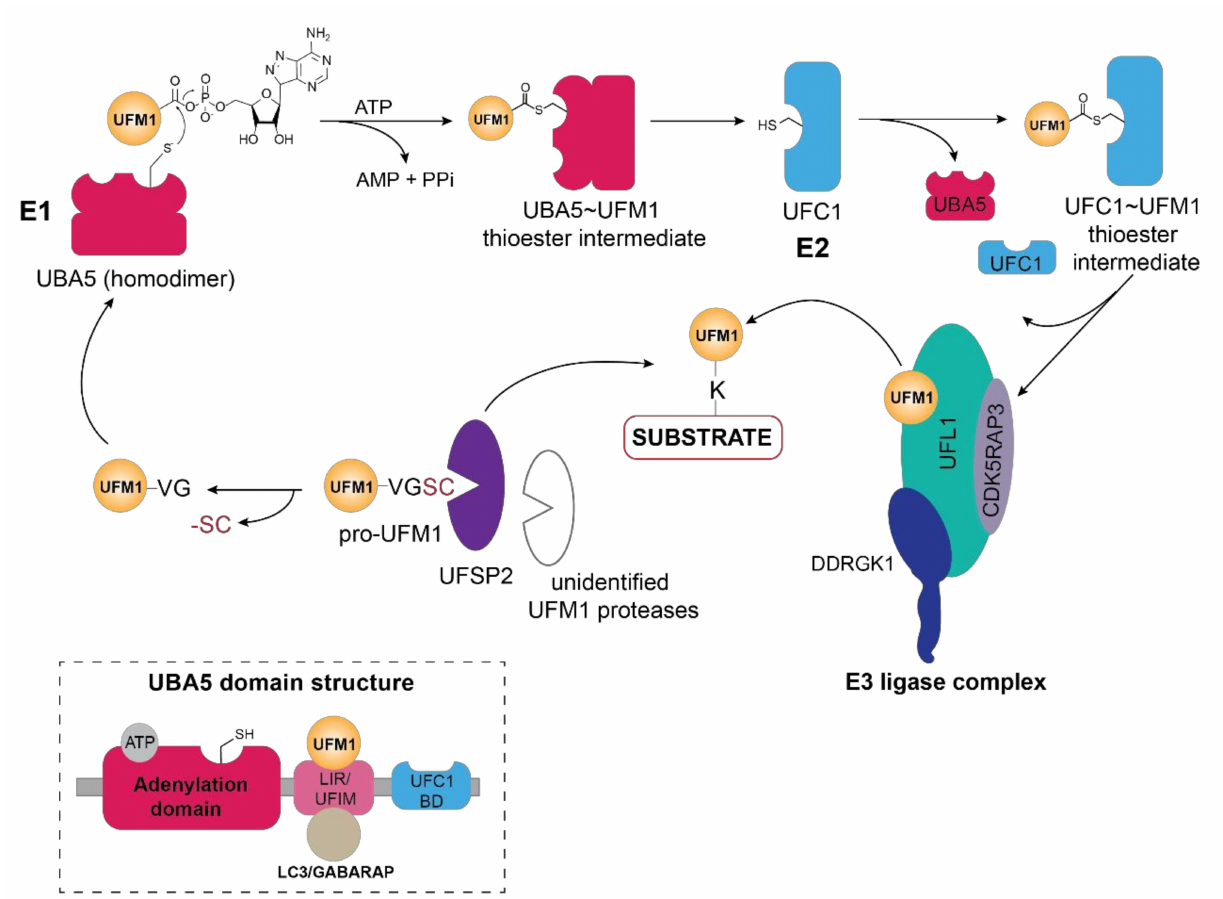
Figure 1. Schematic overview of the UFM1 cascade. In the initial step, the two terminal amino acids (serine and cysteine) are cleaved from pro-UFM1 by UFSP2 and presumably another unidentified UFM1-specific protease [26]. Prior to UFM1 adenylation at the exposed C-terminal glycine residue, UFM1 binds to the UFM1-interacting motif (UFIM)domain of UBA5 (E1), promoting its homodimer formation as well as subsequent UFM1 activation [18]. The UFM1 adenylate intermediate undergoes a nucleophilic attack by the active site cysteine residue of UBA5 yielding the UBA5 ~UFM1 thioester intermediate. Through a transthiolation reaction, activated UFM1 is transferred to the active site cysteine of UFC1 (E2) with the help of the UFC1 binding domain (UFC-BD) of UBA5 [18,19], which then relays the activated UFM1 from the UFC1~UFM1 thioester intermediate via the UFM1 E3 ligase complex to the lysine residue of its substrate proteins. The E3 ligase complex consists of UFL1 and its adaptor proteins DDRGK1 and CDK5RAP3, which stimulate its ligase activity and confer the ER membrane localization of UFL1. Modulation of substrate UFMylation and the resulting cellular response occurs through the action of the UFM1-specific protease UFSP2. Inset depicts the domain organization of UBA5, consisting of the adenylation domain which harbors both the ATP binding pocket and the catalytic site, as well as the LC3-interacting region (LIR) and the UFM1-binding motif (UFIM) and the UFC1-binding domain